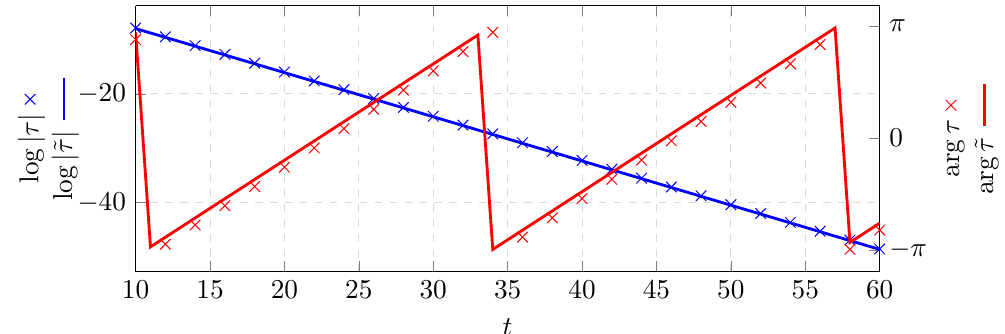
Figure 14: The log and phase of both Fredholm determinant τ -function from (62) and quasi- τ -function ˜ τ from (148) are plotted against time. Solid lines are the ap- proximate ˜ τ , marks are the exact τ . Blue is the modulus, red the phase. The distri- bution is Fermi-Dirac, T = 1.5, x / t = 0.5, N / L = 0.3 and ν = 0.4. In this case (see figure 13), ∆ is non-negligible, so it is one of the more challenging sets of parameters for our model. The unknown constant C from (147) is nonetheless set to zero. The 0 exponent out-competes the power law, hence the line appears